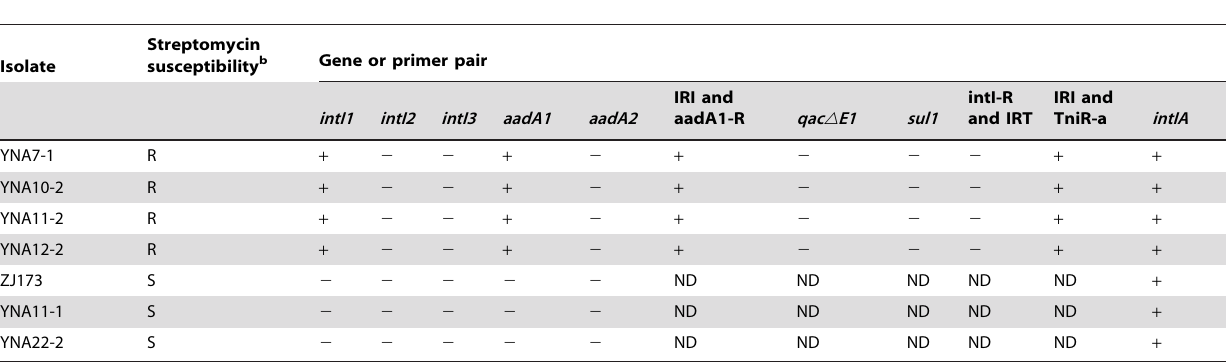
Table 2. PCR amplification of integron-related genes from streptomycin-sensitive and -resistant isolates of X. oryzae pv. oryzae a .